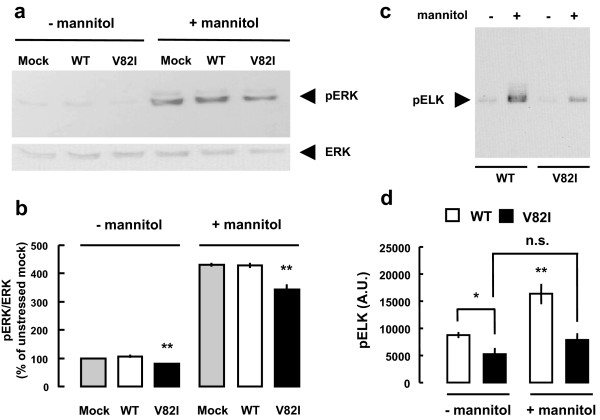
Effects of Cav-3 WT or Cav-3 V82I expression on ERK1/2 activation. BHK cells were transiently transfected with Cav-3 WT or Cav-3 V82I. (a) Cell lysates were subjected to SDS-PAGE and analyzed by immunoblotting using anti-ERK and anti-pERK antibodies. Expression of total cellular level of ERK remained unaltered after the transfection with either Cav-3 WT or Cav-3 V82I in all the conditions tested. On the contrary, a significant decrease in pERK (active form) was observed in the presence of the caveolin-3 mutant, both under resting conditions and after 30 min hyperosmotic stress with mannitol. (b) Quantization revealed that in Cav-3 V82I expressing cells there was a significant decrease of ERK activation as compared with Cav-3 WT and mock transfected cells. Data are representative of three independent experiments. **, P < 0.01 vs the respective mock and Cav-3 WT groups. Similar results were obtained in (c,d). Cell lysates from control and mannitol treated groups were subjected to an in vitro ERK1/2 kinase assay as described in Materials and Methods. Representative blot is shown in (c) and relative band intensities of pElk analysis is shown in (d). Data are representative of three independent cultures. *, P < 0.05 V82I vs WT in untreated cells; **, P < 0.01 WT vs all groups.